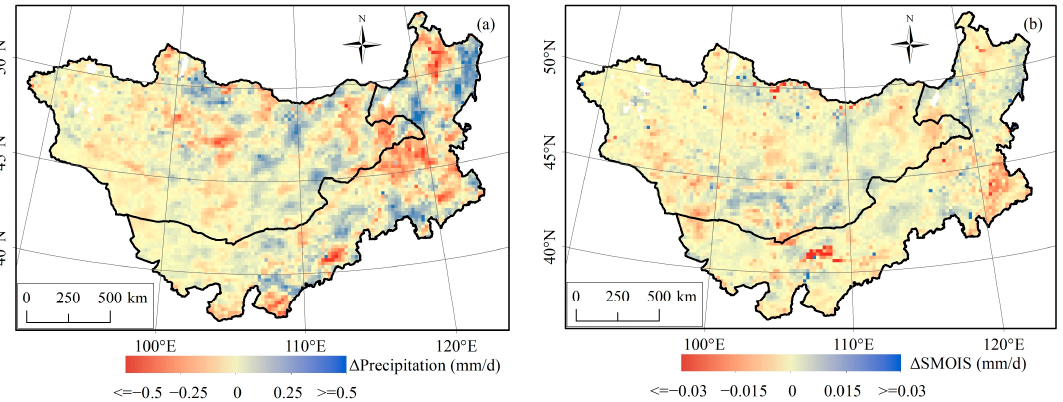
Figure 7. Model-simulated differences in precipitation ( a ), and soil moisture ( b ) due to vegetation changes in the growing season between scenarios of SL1990s and SL2010s.